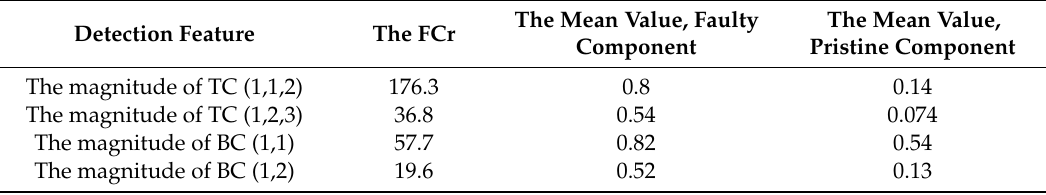
Table 1. Identification effectiveness of the proposed detection features and the bicoherence detection features.